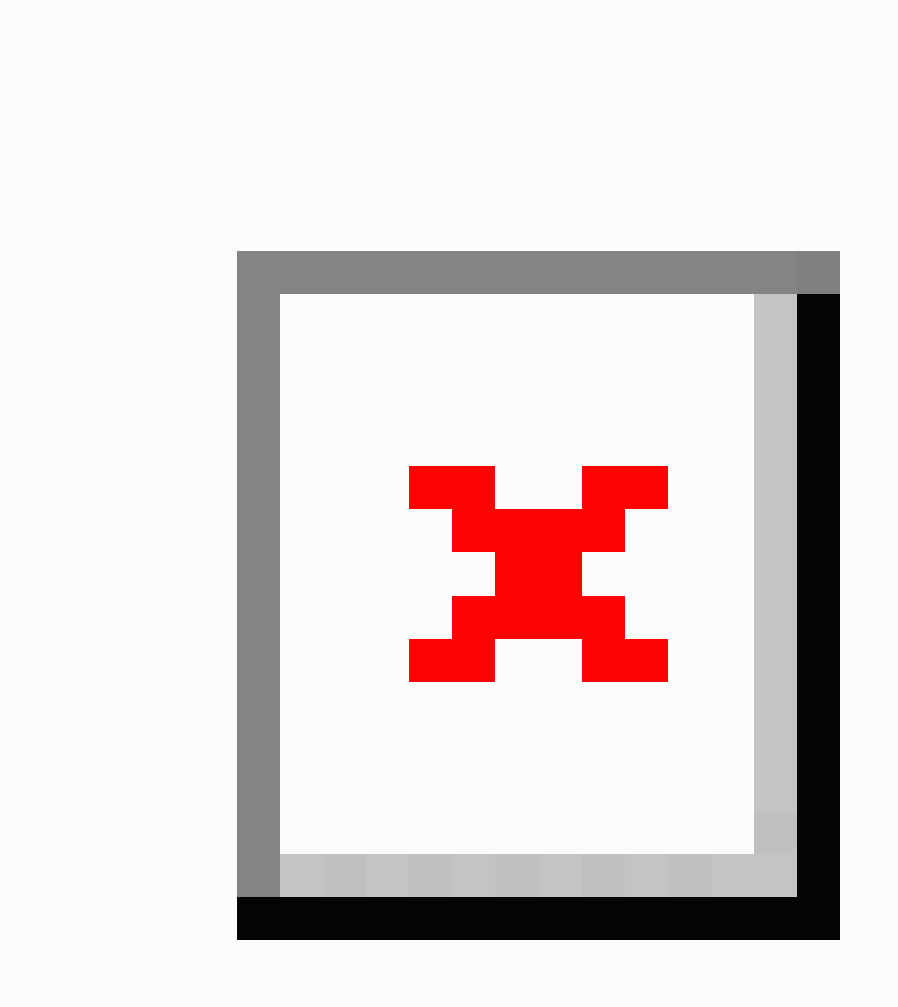
Figure 1. Active Team step-logging